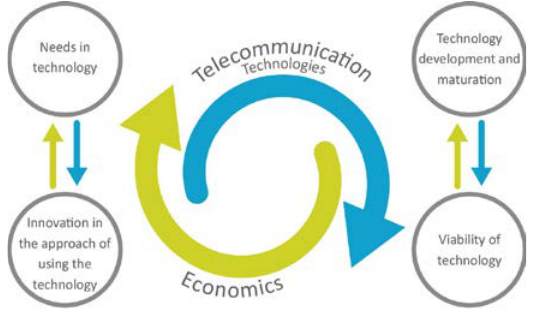
Figure 2 . Tele-Economics described as telecommunica- tions and economics research